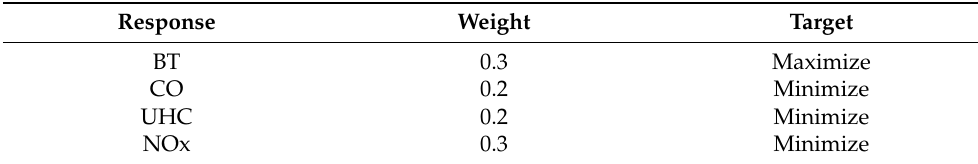
Table 9. The response weights that were employed in multi-objective optimization.